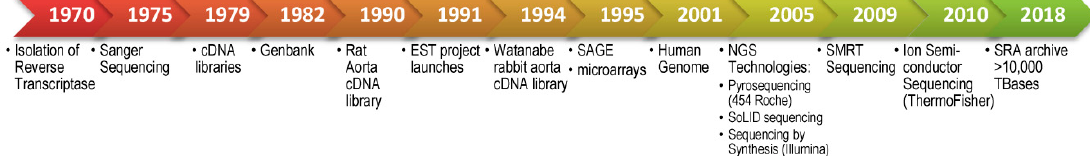
and bioinformatics analysis since the discovery of reverse transcriptase, an enzyme indispensable for any RNA sequencing study. Some of the seminal papers in atherosclerosis research discussed in the text are shown in this timeline as well. Timeline is not to scale. SMRT: single molecule real time.